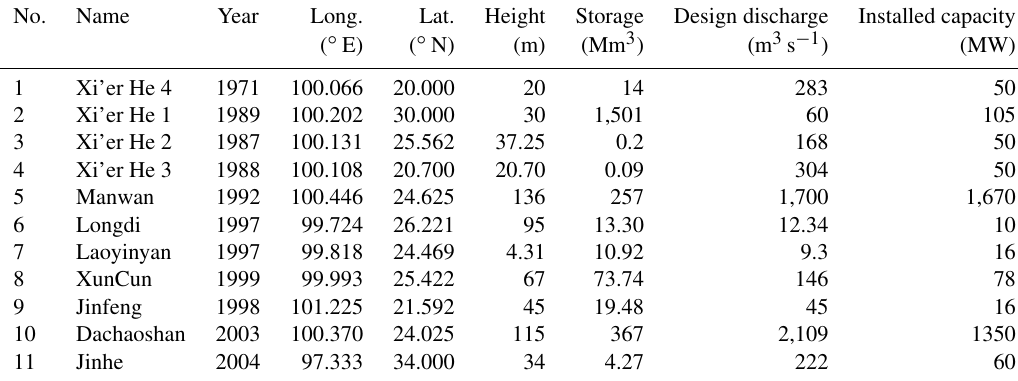
Table 2. Design specifications of the dams implemented in our VIC model (simulation period 1995–2005). The column marked “Year” denotes the year in which each reservoir became operational.